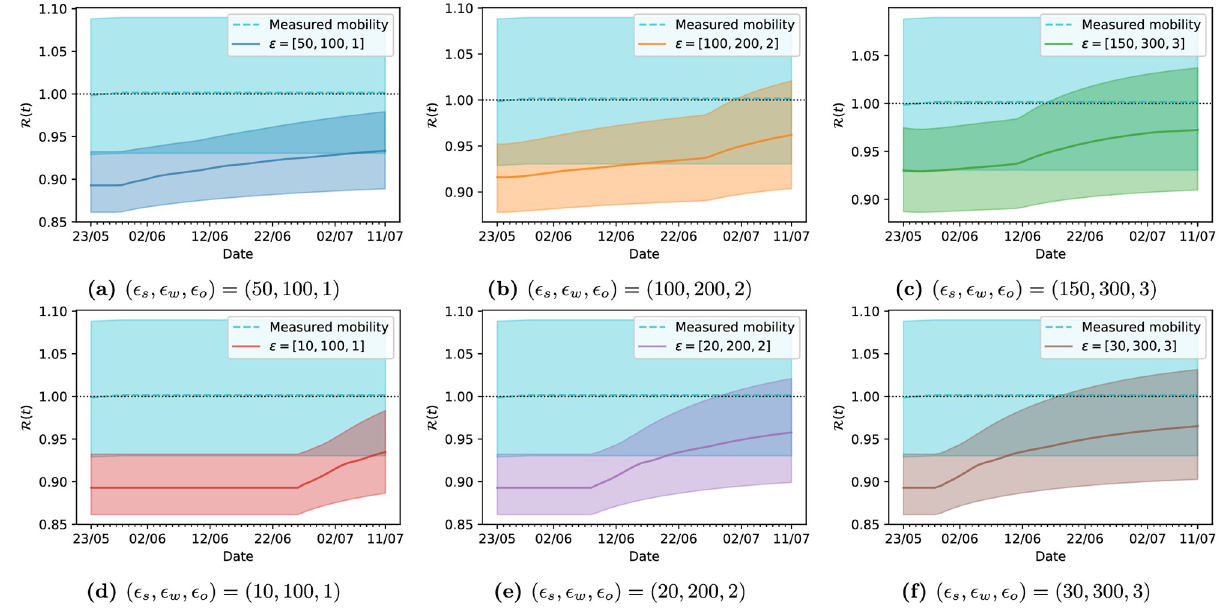
Fig 10. Evolution of R ð t Þ corresponding to different opening strategies starting on the 24th of May, learned using different economic cost weights for different � values, with 99% credibility intervals; these plots are referred to England.